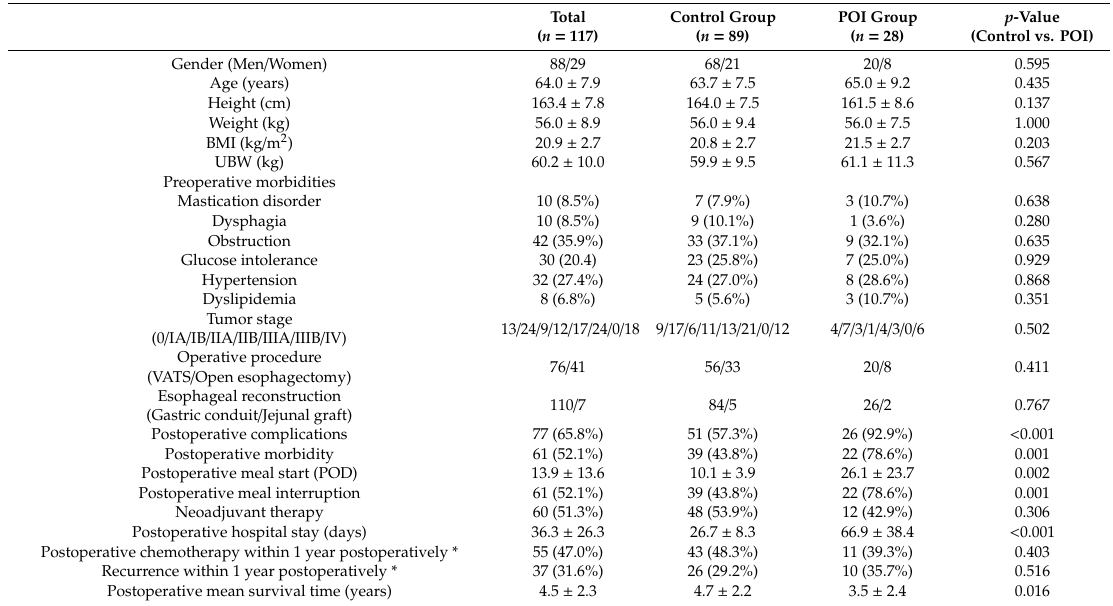
Table 1. Patients’